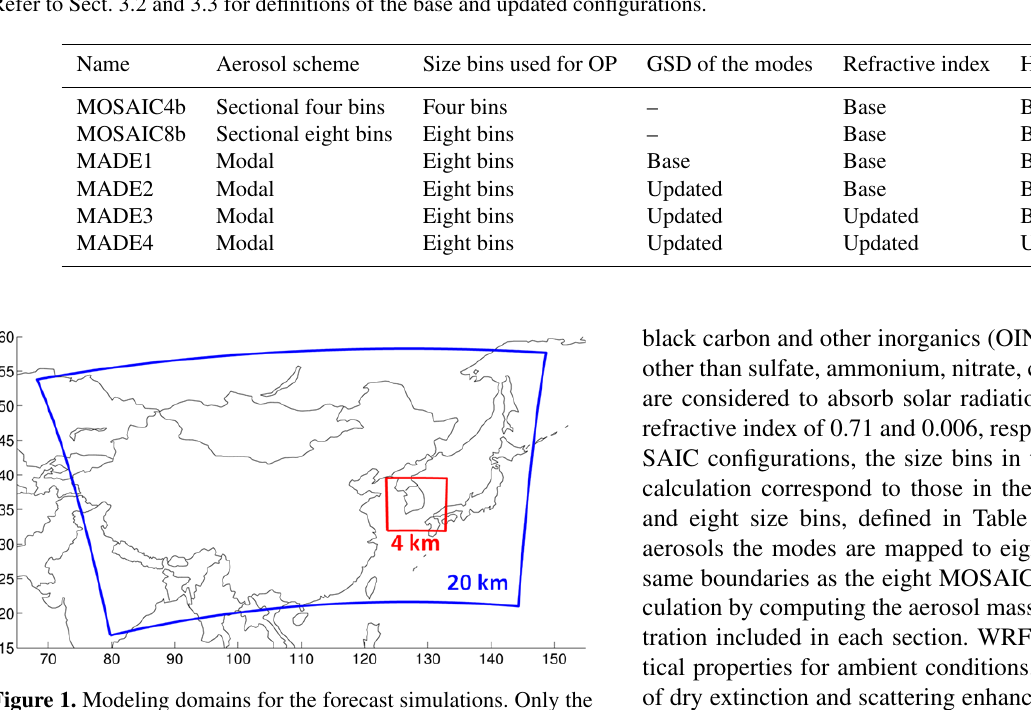
Table 1. Summary of WRF-Chem simulations. Refractive indices, hygroscopicity parameters, and size bins are defined in Tables 2 and 3. Refer to Sect. 3.2 and 3.3 for definitions of the base and updated configurations.